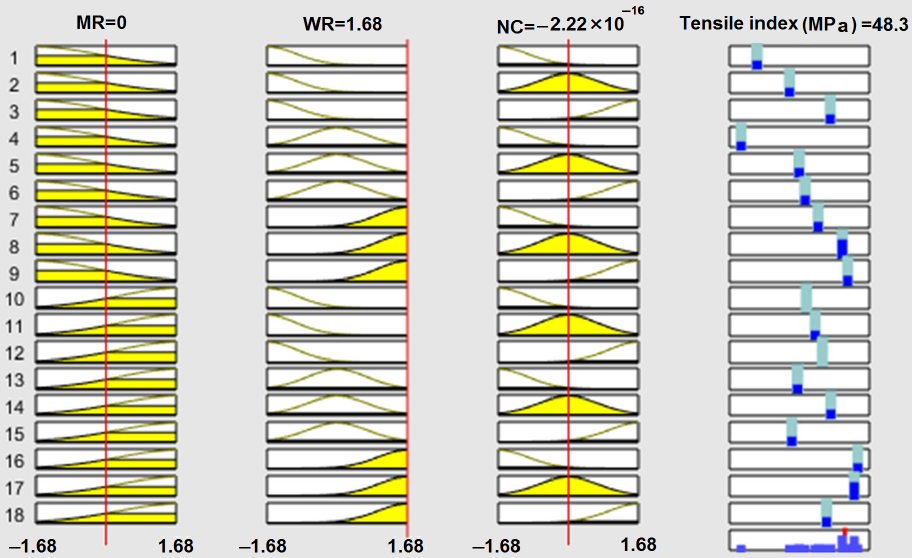
Figure 7. Rule viewer of FIS model for training data (yellow colors and curves show the optimum value of every input and used function, respectively, in each